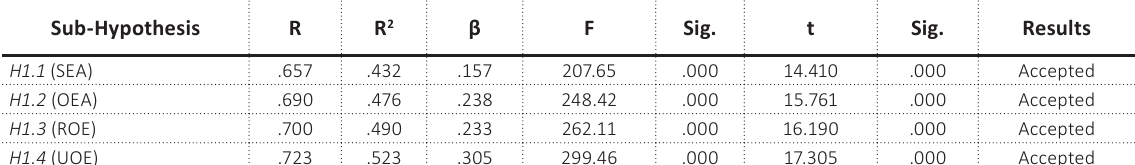
Table 4. Results of sub-hypotheses testing Sub-Hypothesis R R 2